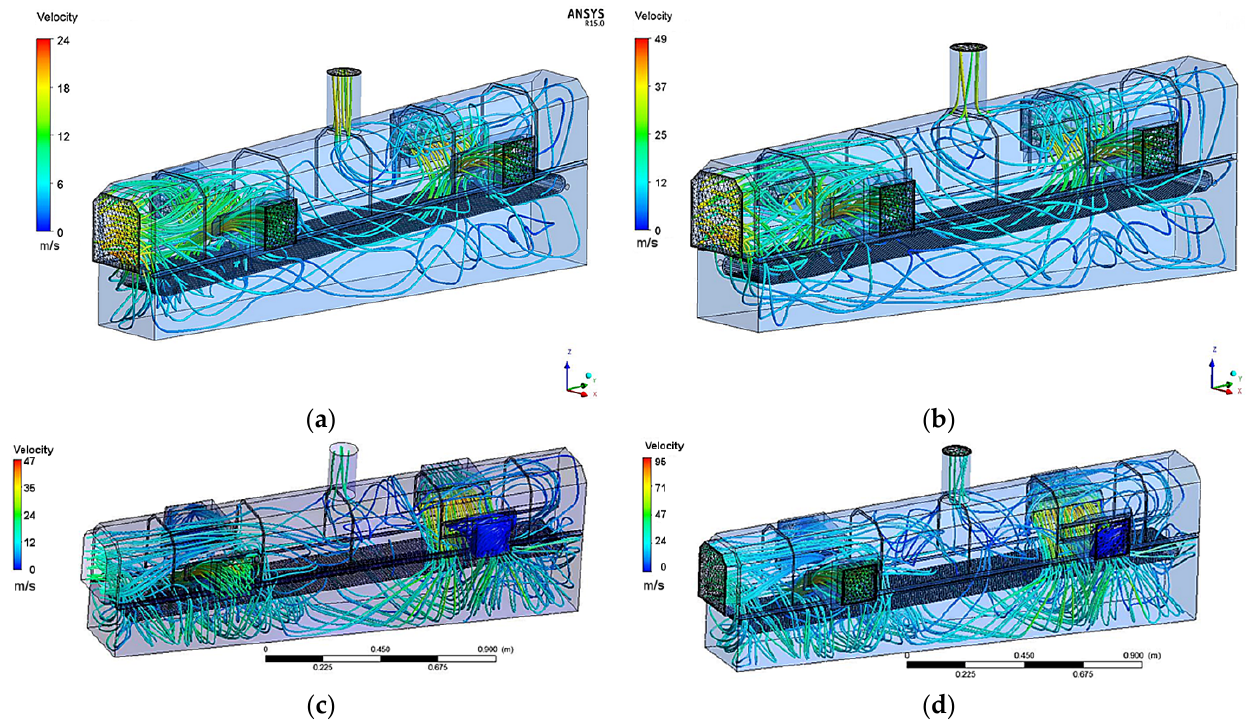
Figure 5. Results of numerical modeling of fluid flow stream lines in the cooling chamber for different setting of air rate: ( a ) 10 m/s—four vents, ( b ) 20 m/s—four vents, ( c ) 10 m/s—2 vents asymmetrical, and ( d ) 20 m/s—2 vents asymmetrical.